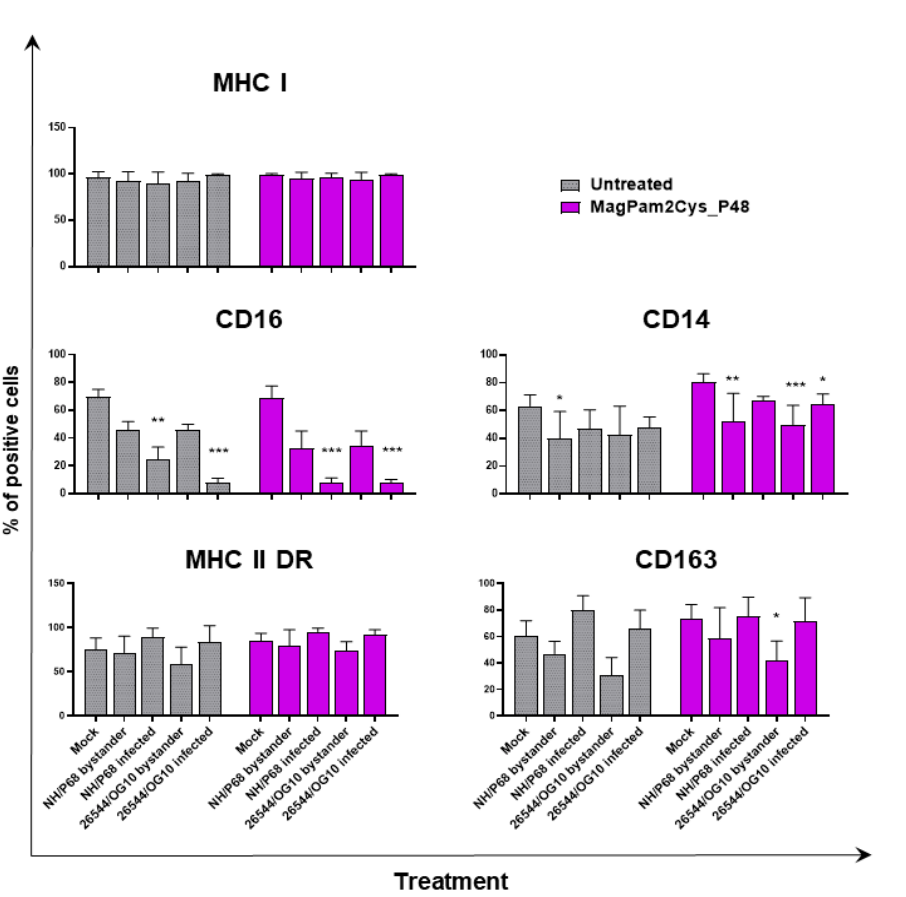
Figure 2. The effect of MagPam2Cys_P48 on ASFV ‐ modulated expression of moM Ф surface markers (percentage of positive cells) . Porcine moM Φ were left untreated or stimulated with MagPam2Cys_P48 (100 ng/mL). Twenty ‐ four hours later, cells were infected with either attenuated NH/P68 or virulent 26544/OG10, using a MOI of 1. Mock ‐ infected samples were used as controls. At 21 hpi, flow cytometry was employed to determine surface expression of MHC I, CD16, CD14, MHC II DR, and CD163, and intracellular levels of ASFV late protein p72. The mean data + SD from three independent experiments utilizing different blood donors are displayed. For each surface marker, percentages of positive cells are presented. Values of ASFV ‐ infected or bystander cells were compared to the corresponding mock ‐ infected control using a one ‐ way ANOVA followed by Dun ‐ nett’s multiple comparison test or a Kruskal–Wallis test followed by Dunn’s multiple comparison test; *** p < 0.001, ** p < 0.01, * p < 0.05.